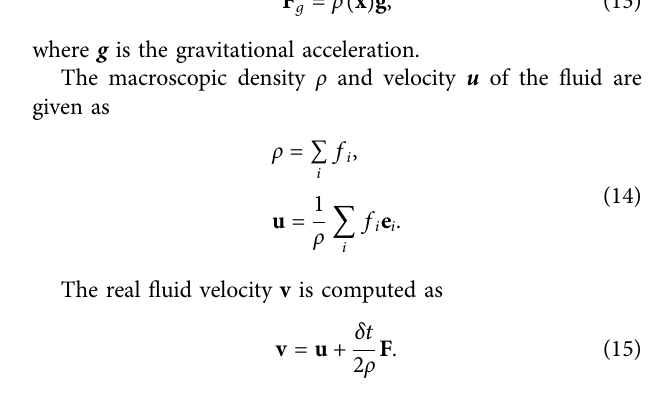
Frontiers in Energy Research |